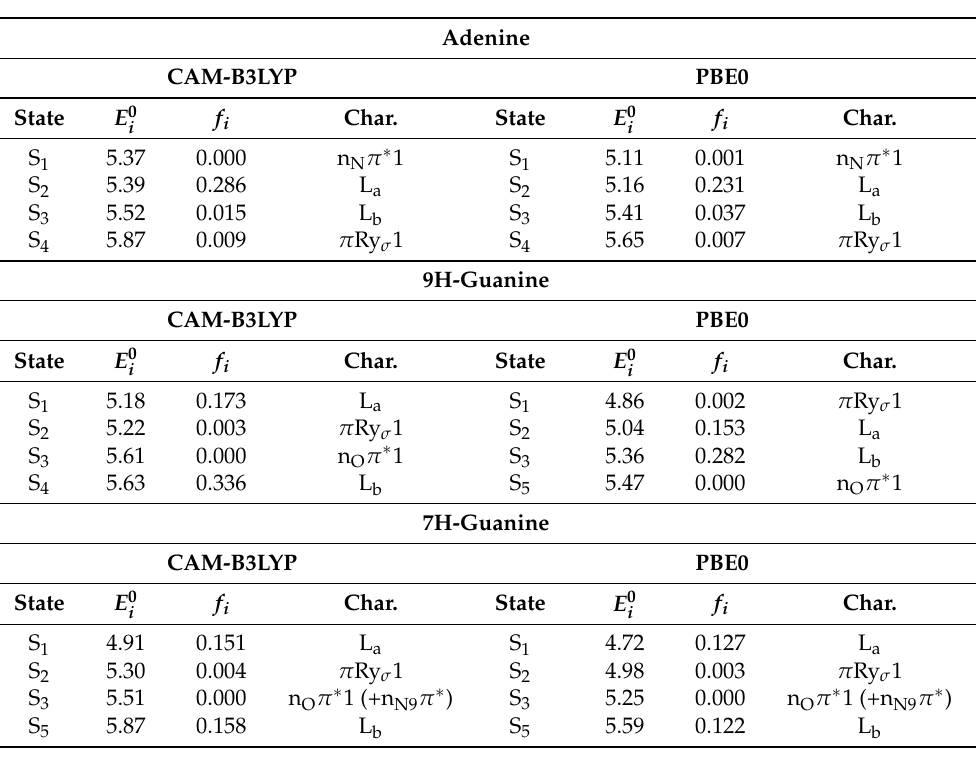
Table 2. Energies ( E 0 ), oscillator strengths f i , and electronic characters for the predominant excited i states of the purine bases involved in the dynamics, calculated at the ground-state minimum (FC point, C s symmetry). CAM-B3LYP and PBE0 calculations with 6-311+G(d,p) basis set in gas phase. Energies in